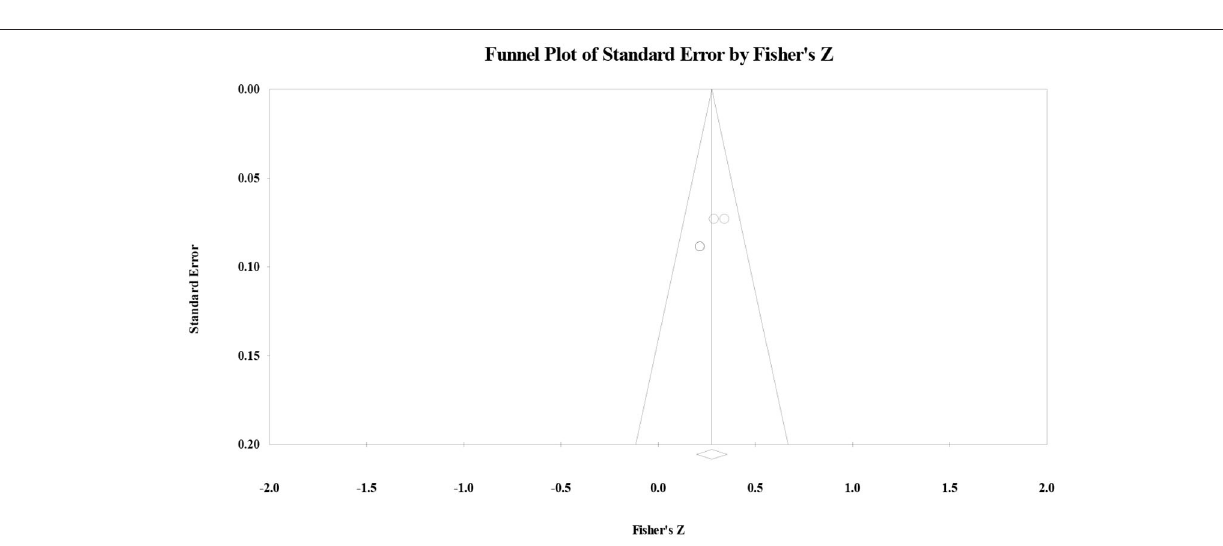
FIGURE 5 | Funnel plot of the correlation effect size between vocabulary knowledge and reading comprehension for Master